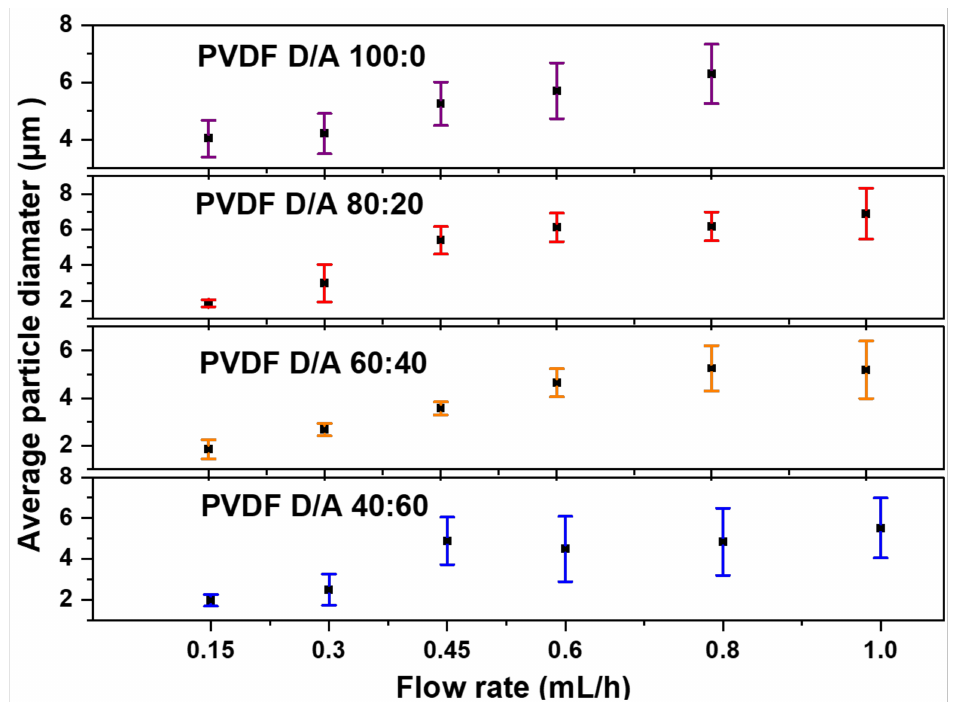
Figure 3. Average PVDF microparticle size distribution of electrosprayed samples varying the flow rate and DMF/ACE solvent